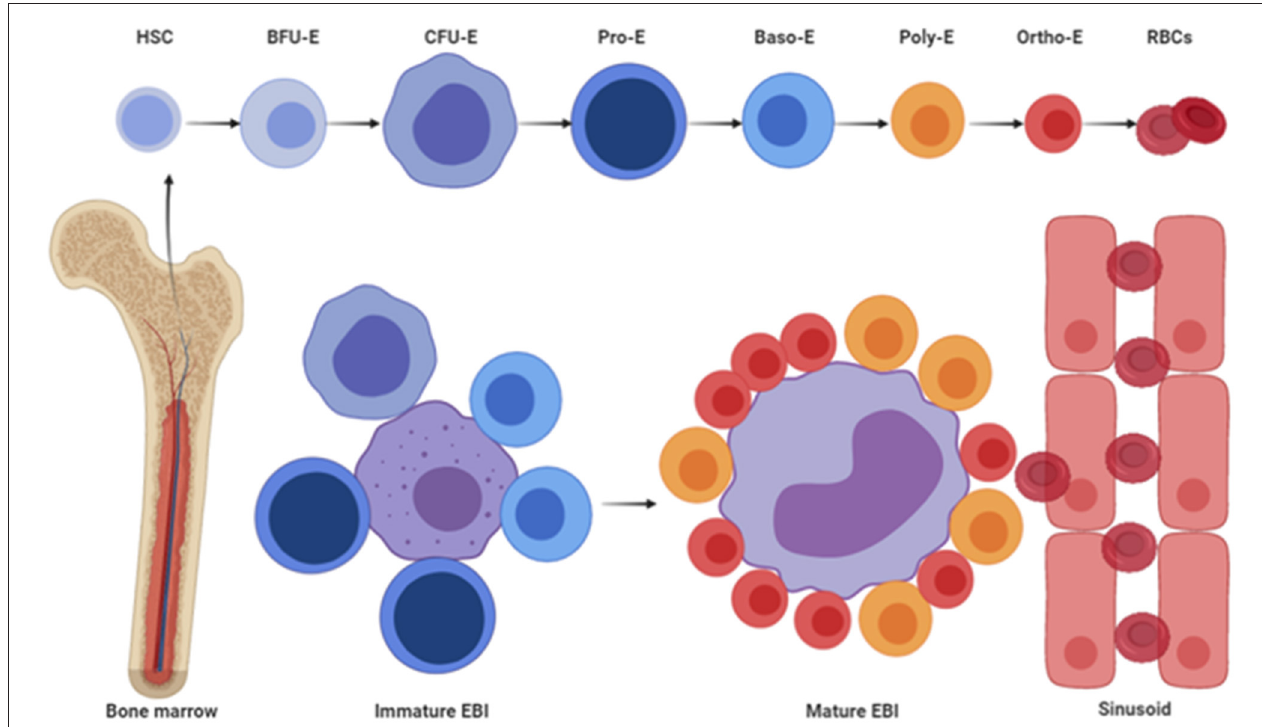
FIGURE 1 | Schematic diagram of two types of EBIs and the process of EBI